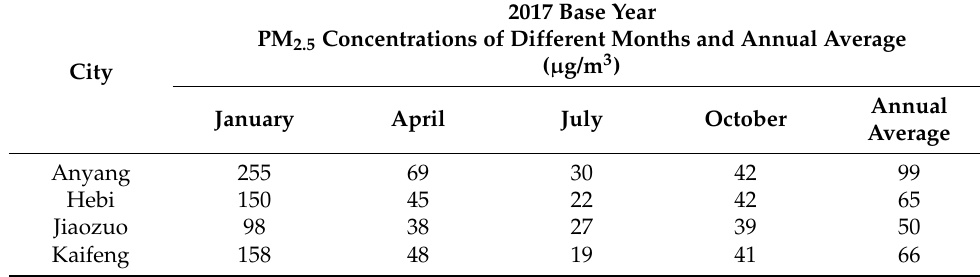
Table 5. PM 2.5 concentrations in the 2017 base